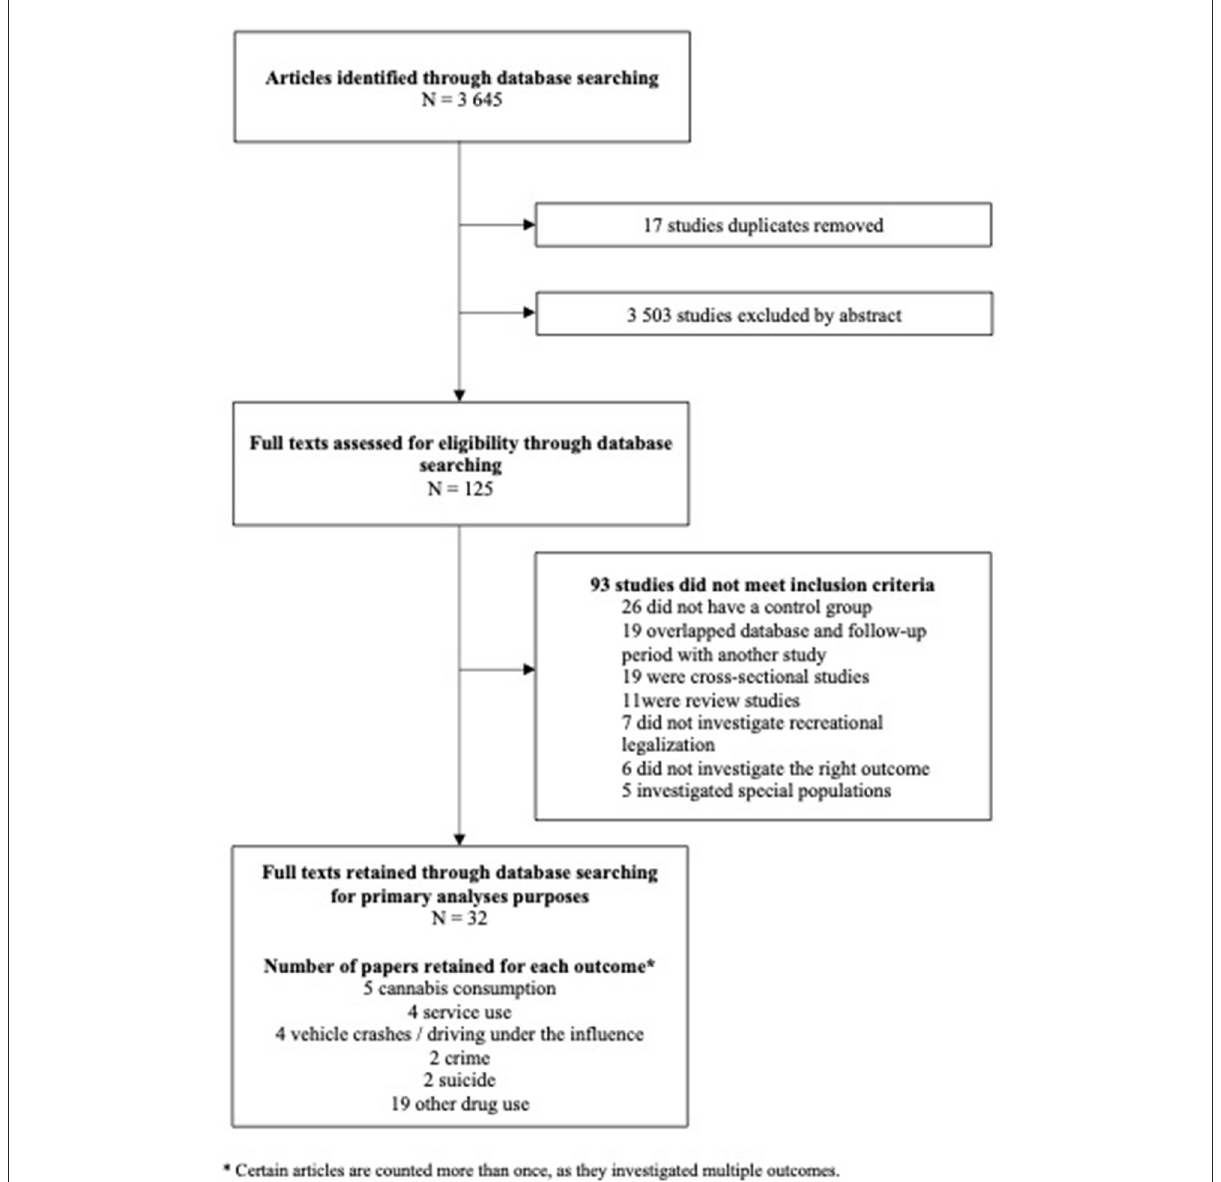
FIGURE1 PRISMA flow Chart for the impact of the legalization of recreational cannabis on key public health